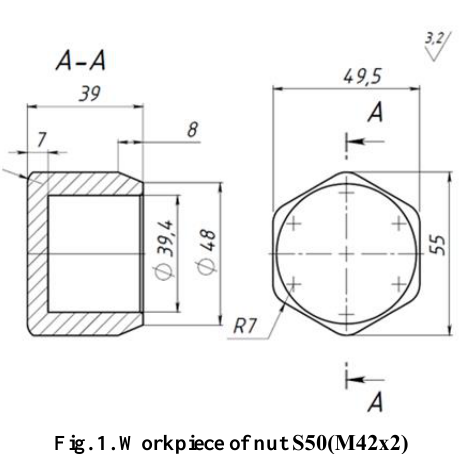
Fig. 1. Workpiece of nut S50(М42х2)